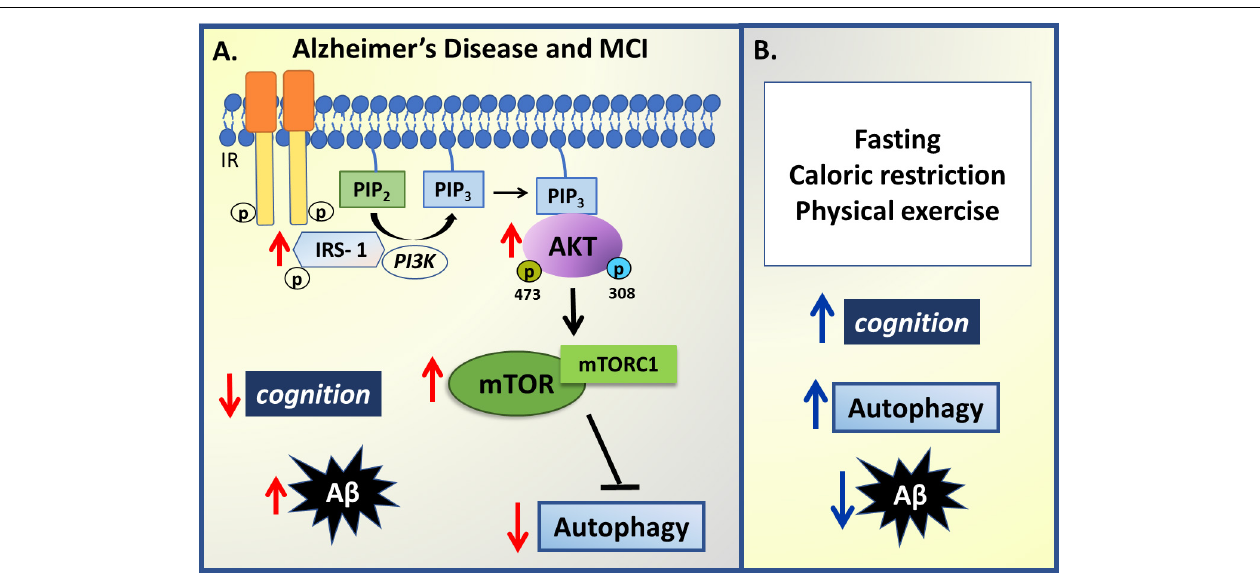
FIGURE 3 | Summary of insulin –autophagy signaling changes in Alzheimer’s disease. (A) In mild cognitive impairment (MCI) and Alzheimer’s Disease, an inverse correlation between cognition levels, insulin sensitivity, autophagy and amyloid- β (A β ) aggregates is observed. An increase in IRS-1, PI3K and AKT phosphorylation coupled to mTORC1 hyperactivation downregulates autophagy activity, impairing A β degradation, which results in increased A β deposition and decreased cognition performance. (B) However, some non-pharmacological strategies have been presented to modulate some changes observed in AD and MCI such as fasting protocols, caloric restriction and physical exercise that can improve cognitive performance, increase autophagy and thus decrease A β aggregates. Red arrows represent changes in pathophysiology and blue arrows represent changes promoted by non-pharmacological